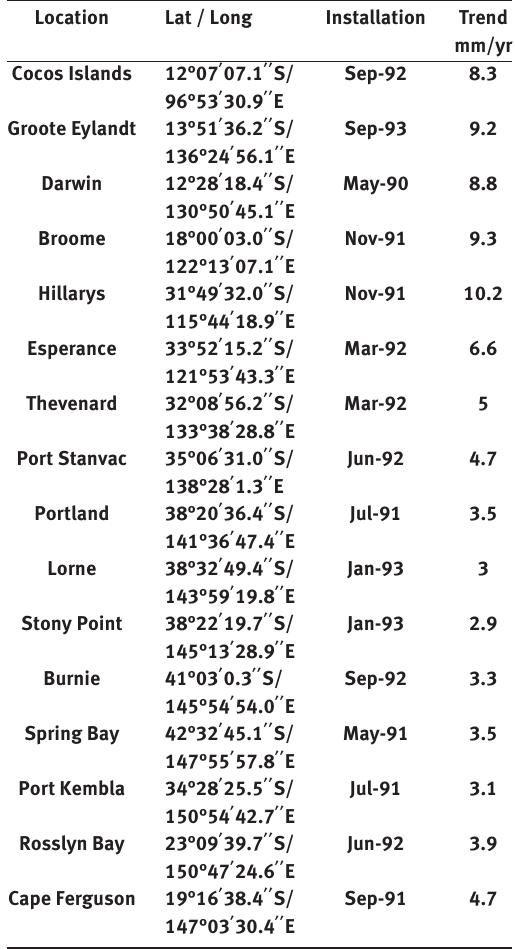
Table 1. Recent short-term sea level trends in The Australian Base- line Sea Level Monitoring project area based upon SEAFRAME data through June, 2012 (from